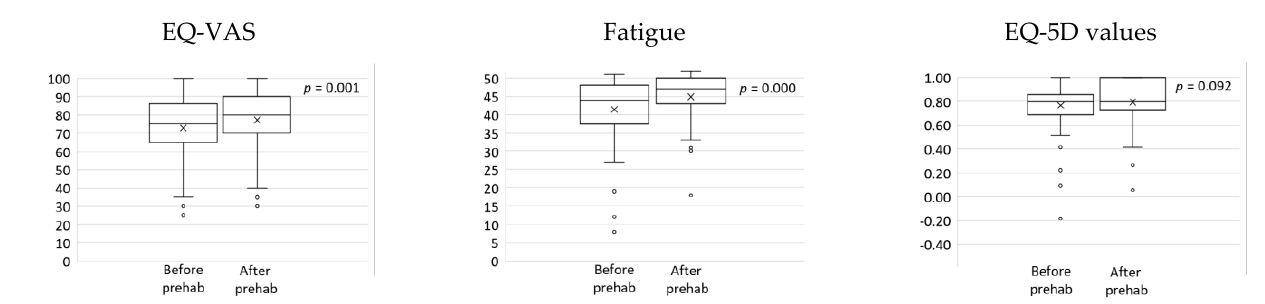
Figure 3. Boxplots depicting self-rated health (EQ-VAS), fatigue, and EQ-5D values, before and after prehabilitation. Statistically significant improvements were found in self-rated health ( p = 0.001) and fatigue ( p = 0.000).